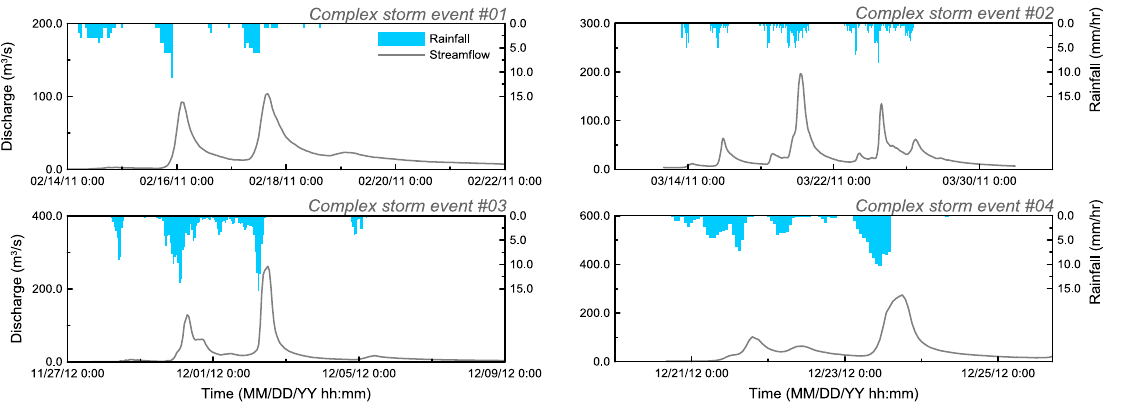
Figure 4. Rainfall hyetographs and hydrographs of the four complex storm events addressed in this study. Table 2. Characteristics of the applied storm events. Complex Independent Storm Event No. Rainfall No.